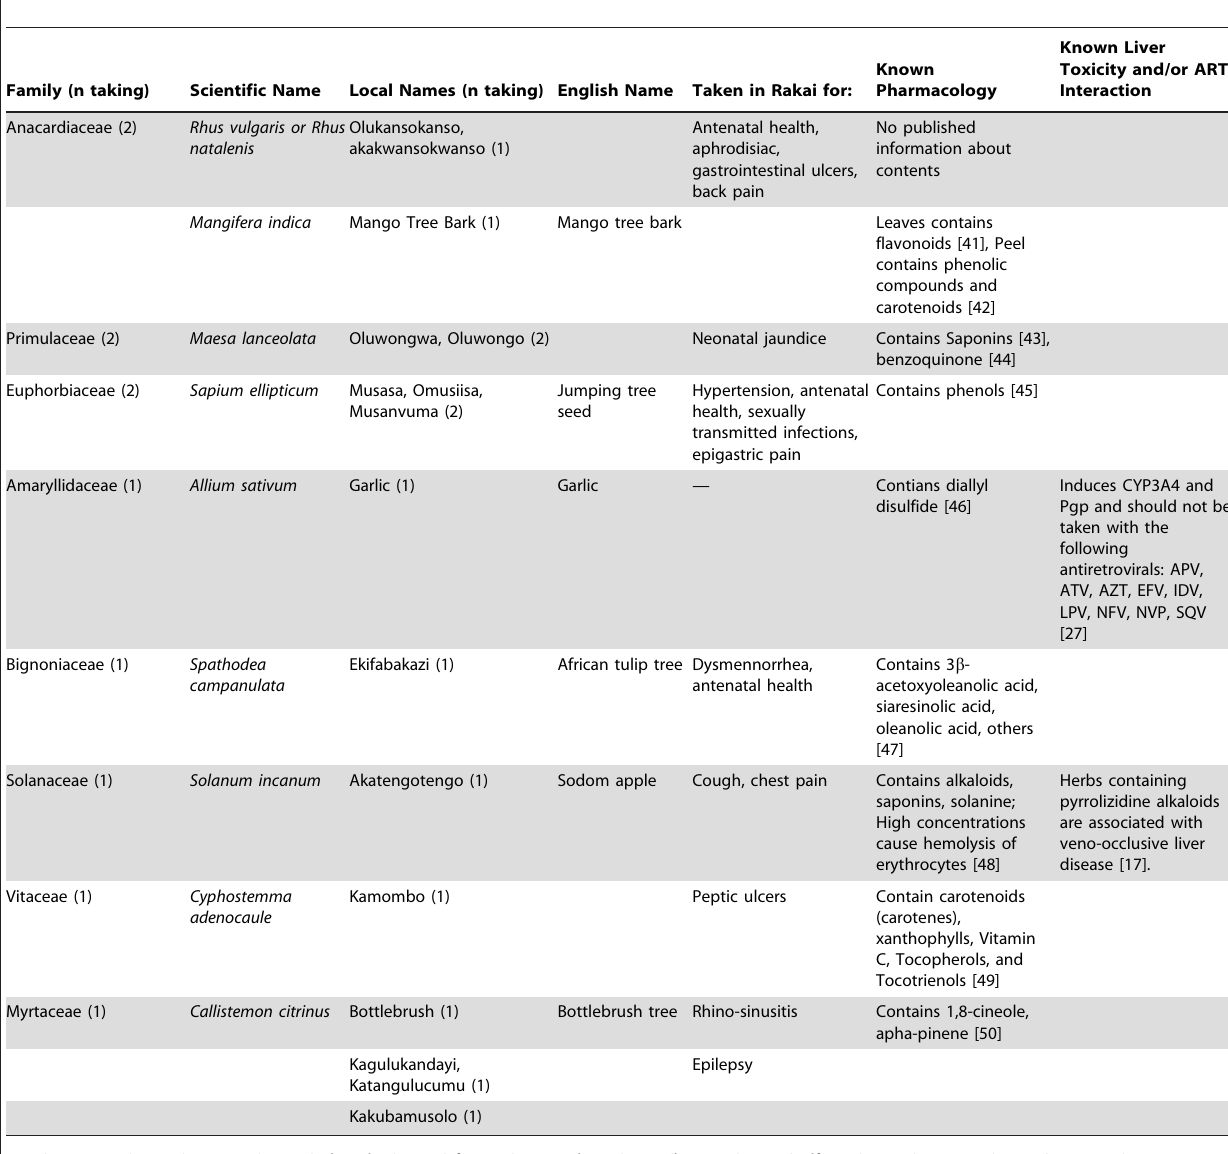
Table 4. Characteristics of known herbs in remainder of plant families.